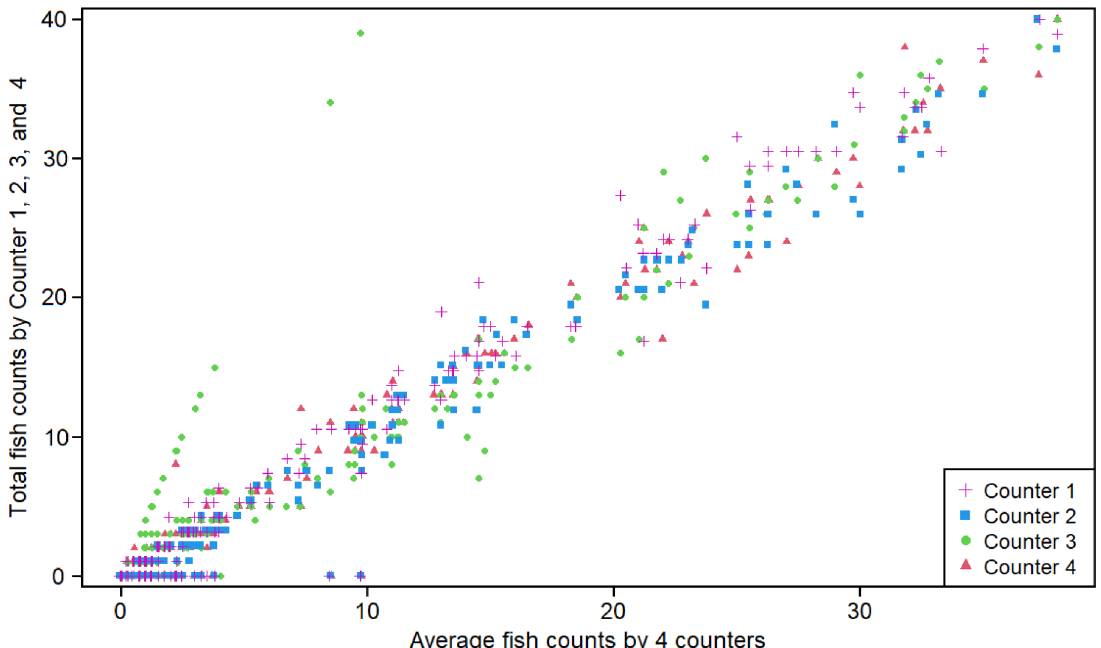
Fig. 7. Manual fish count results by Counters 1, 2, 3, and 4 in the 864 images taken around the test cage (Cage 1 on 8 July). Each mark represents the number of detected fish in each image; x -axis is the average count in each image by the 4